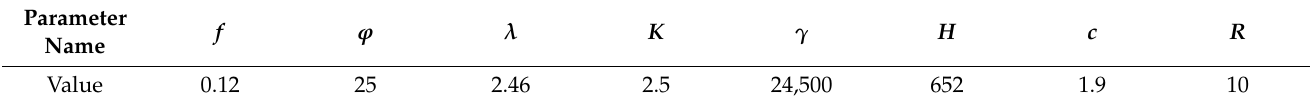
Table 1. Calculation parameters for the width of the section coal pillar yield